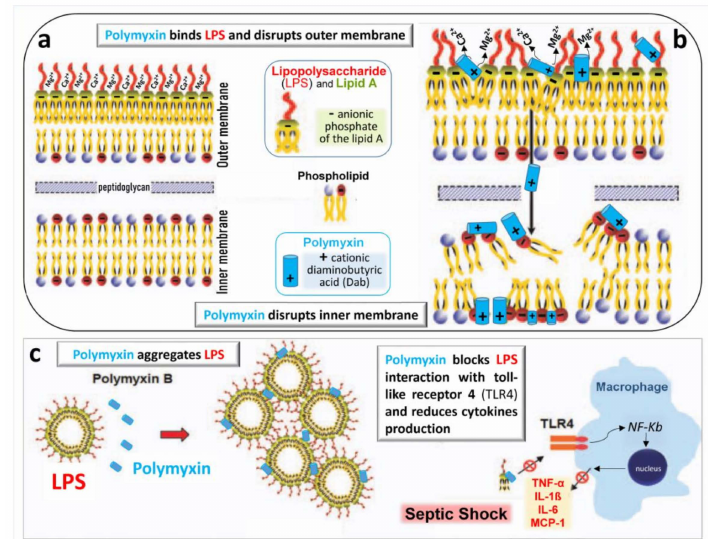
Figure 4. Schematic representation of the bactericidal action of polymyxins. ( a ) The outer membrane of the Gram-negative bacterial wall is stabilized by the electrostatic interaction between divalent cations Ca ++ and Mg ++ and negatively charged phosphodiesters of lipid A of lipopolysaccharide (LPS), thereby creating a permeability barrier against harmful external agents. ( b ) Polymyxins disrupt the physiological bridges LPS/lipid A. The positively charged Dab interacts electrostatically with negatively charged phospholipids of the LPS, producing the leakage of cellular components through the disrupted bacterial membrane. The mechanisms by which polymyxins disrupt the bacterial inner membrane remain undetermined. ( c ) Polymyxins aggregate free LPS released from the bacterial wall and block LPS interaction with macrophage receptor, TLR4. The NF-kB pathway is no longer stimulated, and release of pro-inflammatory cytokines such as tumor-necrosing factor- α (TNF- α ), interleukins 1 β and 6 (IL-1 β and IL6) and monocyte chemoattractant protein 1 (MCP-1) is limited, reducing the sepsis severity